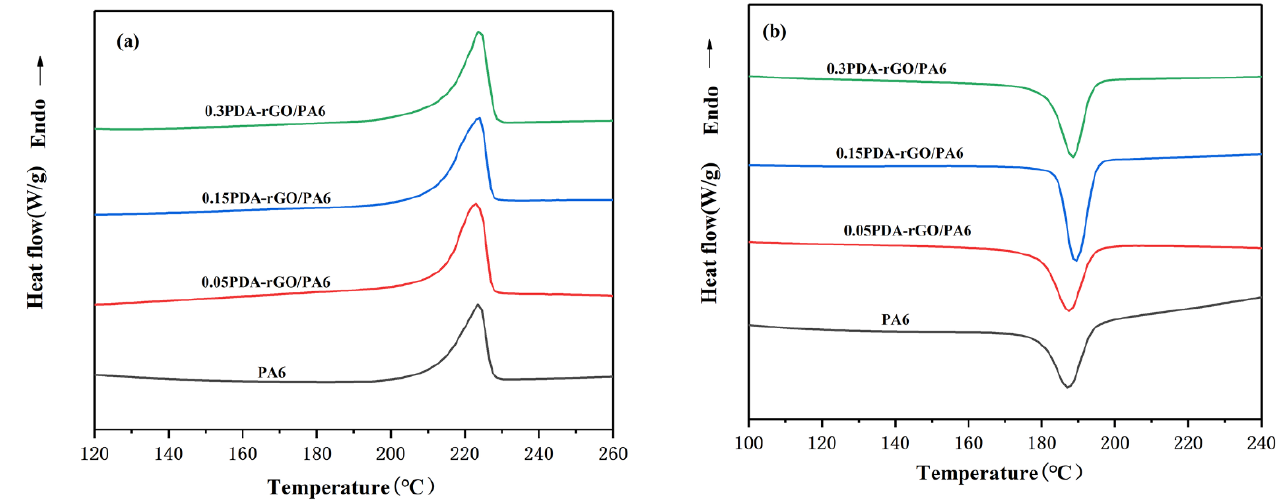
Table 2. DSC data of PA6 fiber and composite fibers containing different PDA-rGO content.